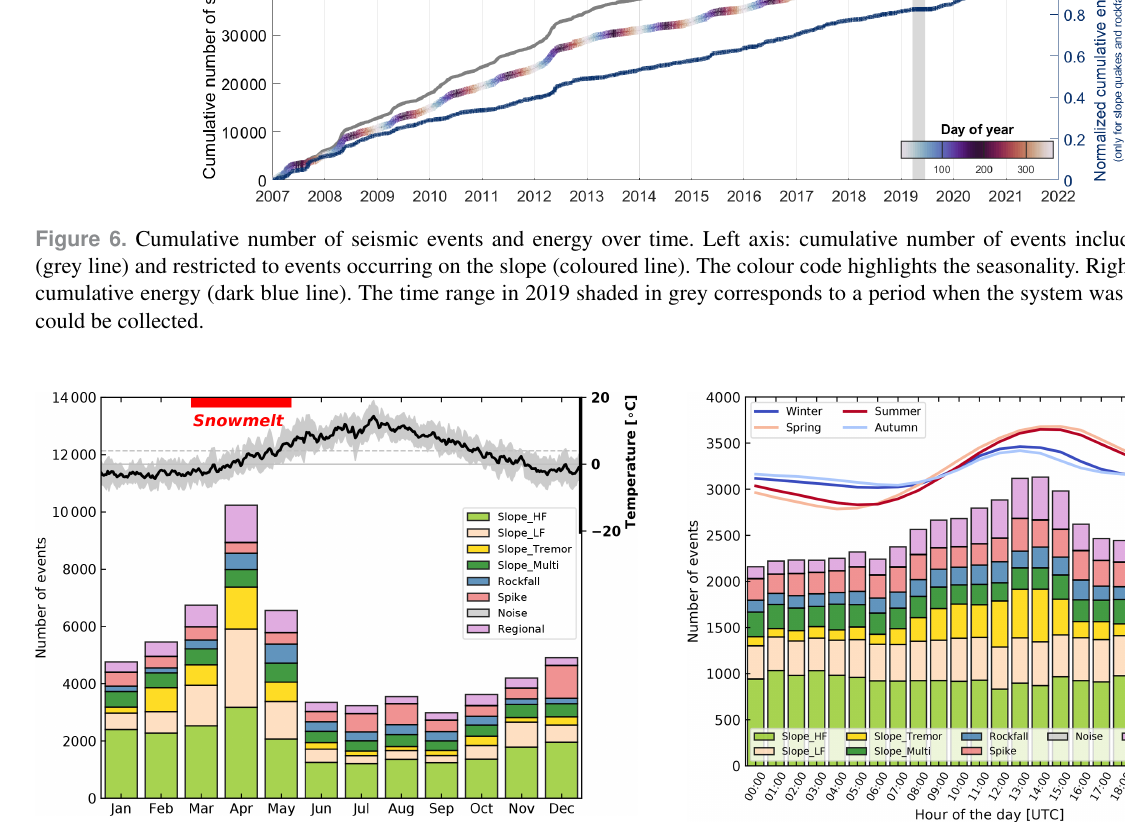
Figure 7. Seasonality of events and temperature per month for 15 years of data (2007–2021). Left axis: number of events. Bars are subdivided into event classes; noise records are not visible, since they are sparse. Top right axis: average temperature (black line) in- cluding standard deviation (grey shade). Solid and dashed horizon- tal grey lines indicate temperatures of 0 and + 4 ◦ C, respectively.